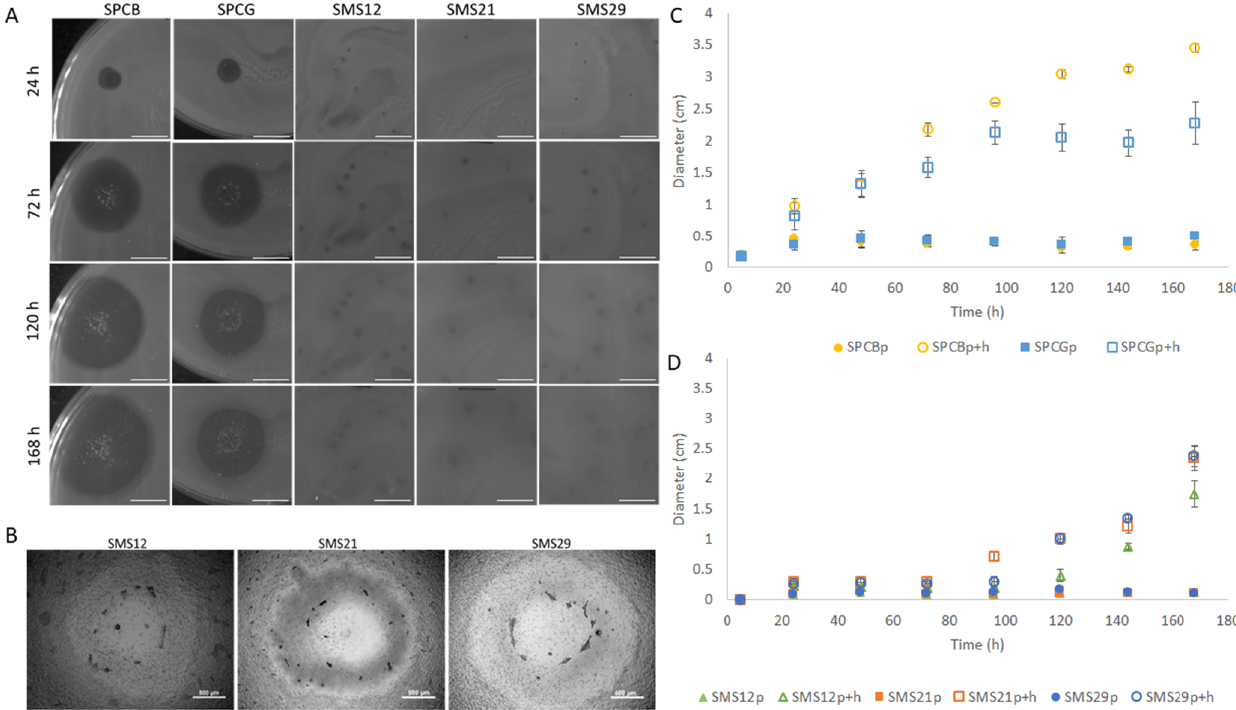
Figure 2. Plaque characteristics of the five phages used in this work after 24, 72, 120, and 168 h: ( A ) morphological characteristics (scale bar 1 cm); ( B ) microscopy of phages SMS12, SMS21, and SMS29 (5× objective) (scale bar 500 µm); ( C ) plaque diameters of phages SPCB and SPCG); ( D ) plaque diameters of phages SMS12, SMS21, and SMS2. Data in ( C ) and ( D ) are shown either as mean of plaque diameter (p) ± SD or mean of plaque and halo diameter (p + h) ± SD.